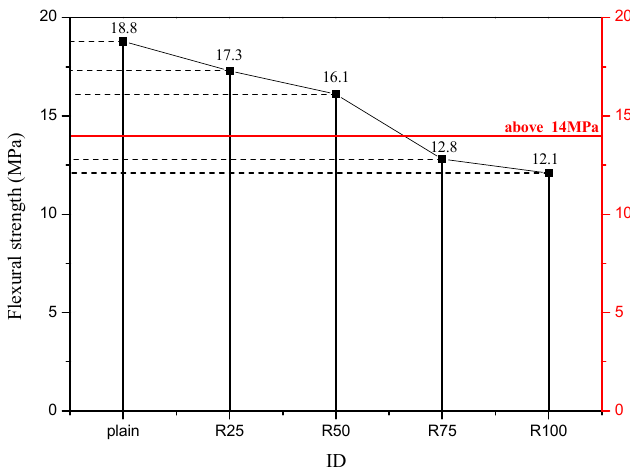
Figure 8. Flexural strength of bar type specimens.